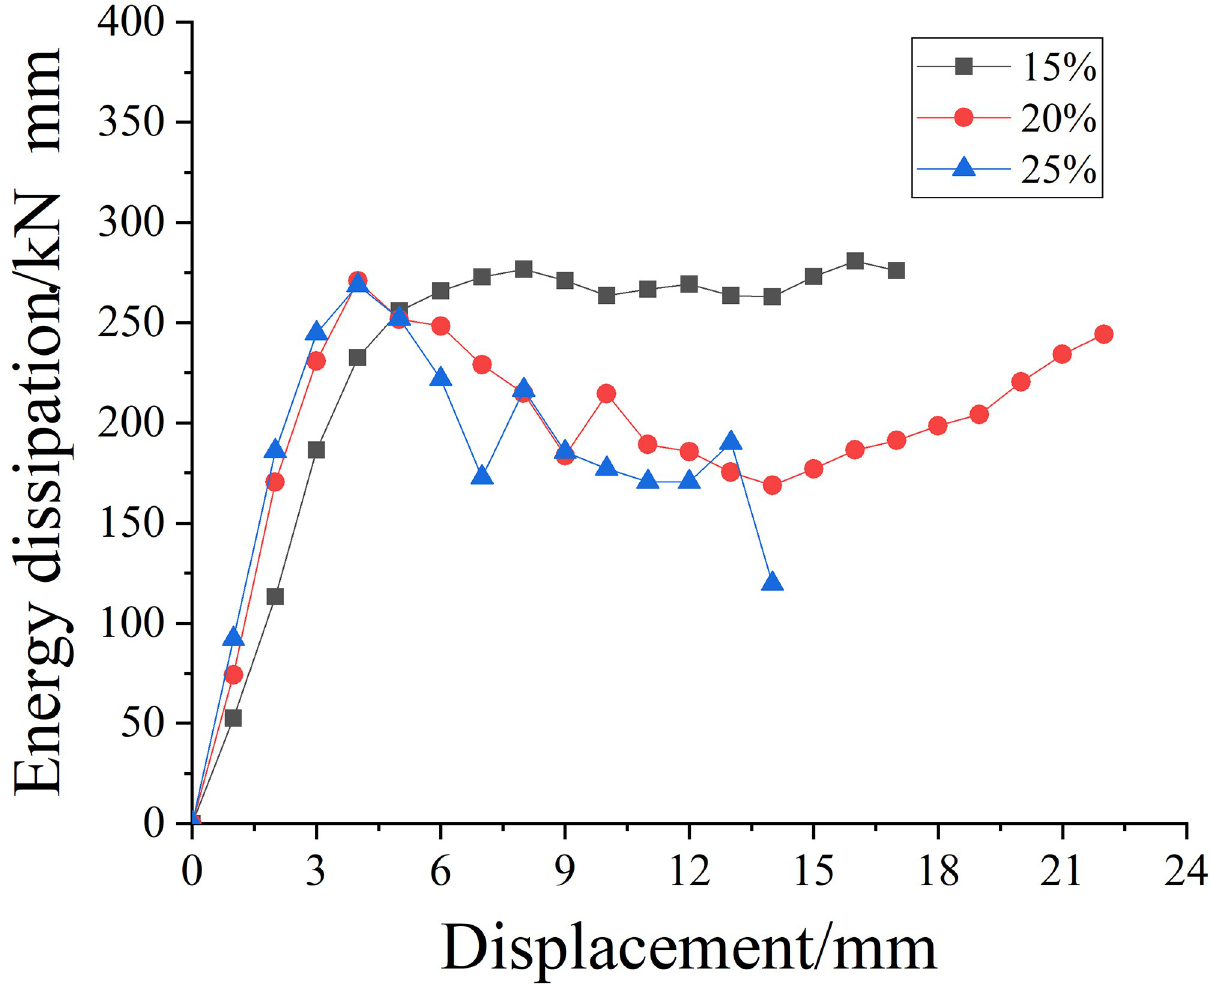
Fig 11. Energy dissipation displacement curves of specimens strengthened with SMA in different concentrations of salt solution.